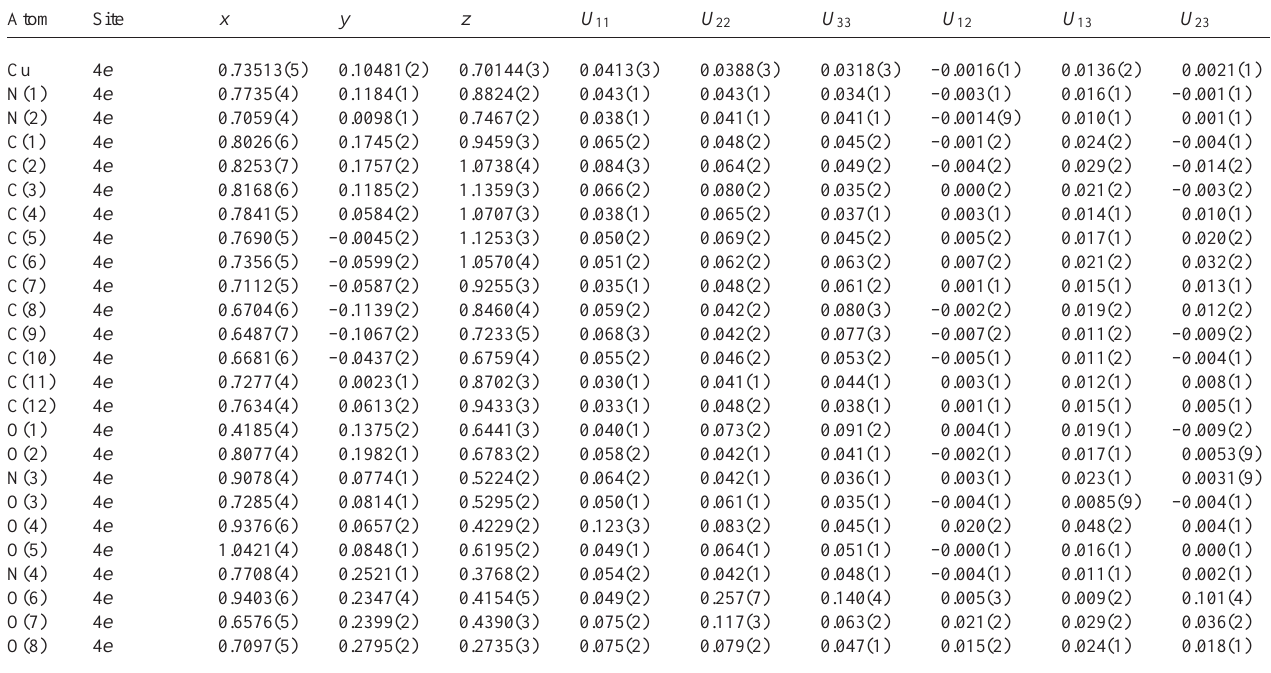
Table 3. Atomic coordinates and displacement parameters (in Å 2 )